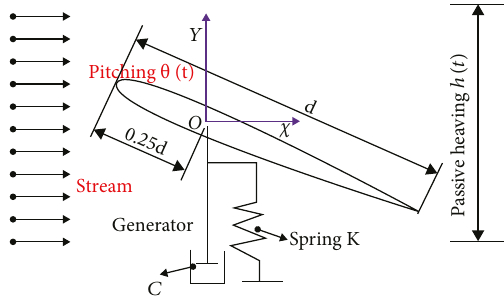
Figure 1: The schematic view of the semiactive fl apping